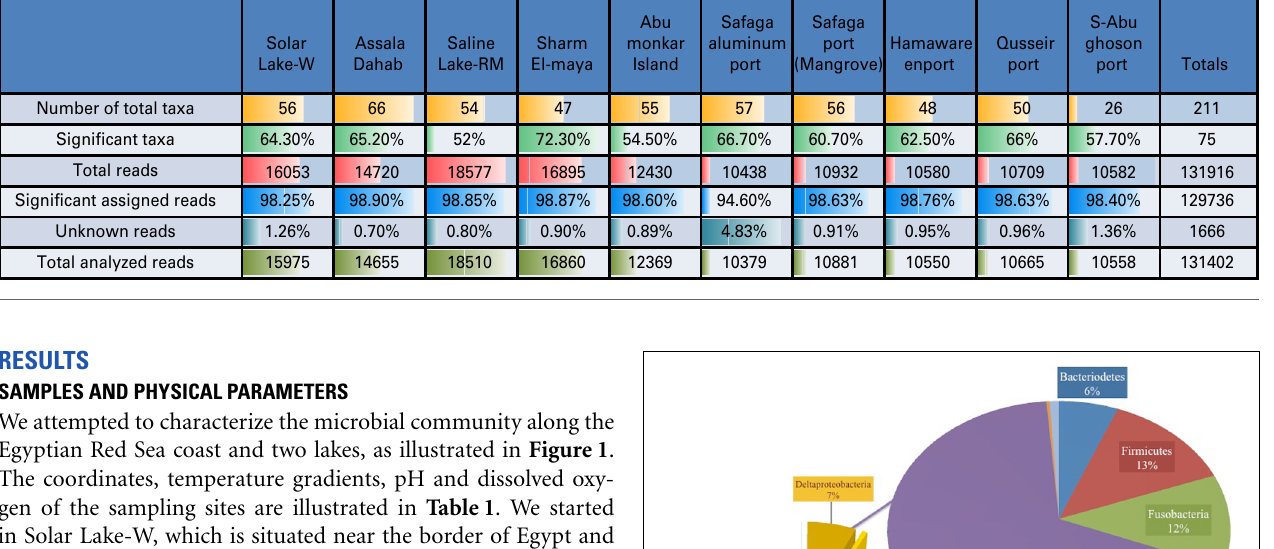
(0.03%) ( Figure 2 ). Members of Proteobacteria included γ - proteobacteria (92%), followed by δ –proteobacteria (7%) and ε -proteobacteria (1%) ( Figure 2 , Table 3 ). Very low propor- tions of unassigned organisms were detected across sites